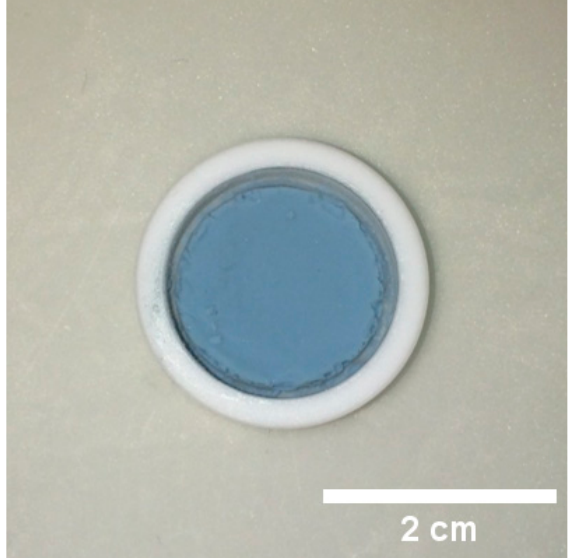
Figure 7. Photograph of ITO aerogel B (15 at.% Sn) after CPD in a Teflon cup. The X-ray diffractograms of the products of both syntheses indicate high crystallinity of both the initially formed nanoparticles and the aerogels. In all samples, a cubic bixbyite structure of In 2 O 3 (ICDD PDF No. 01-088-2160) was observed without crystalline impurities. Furthermore, no significant changes in the reflections during annealing at temperatures of 400–600 ◦ C in air were observed (Figure S3). Nevertheless, the crystallite size of the aerogels remained practically constant up to 400–500 ◦ C but increased significantly during calcination at 600 ◦ C (Figure